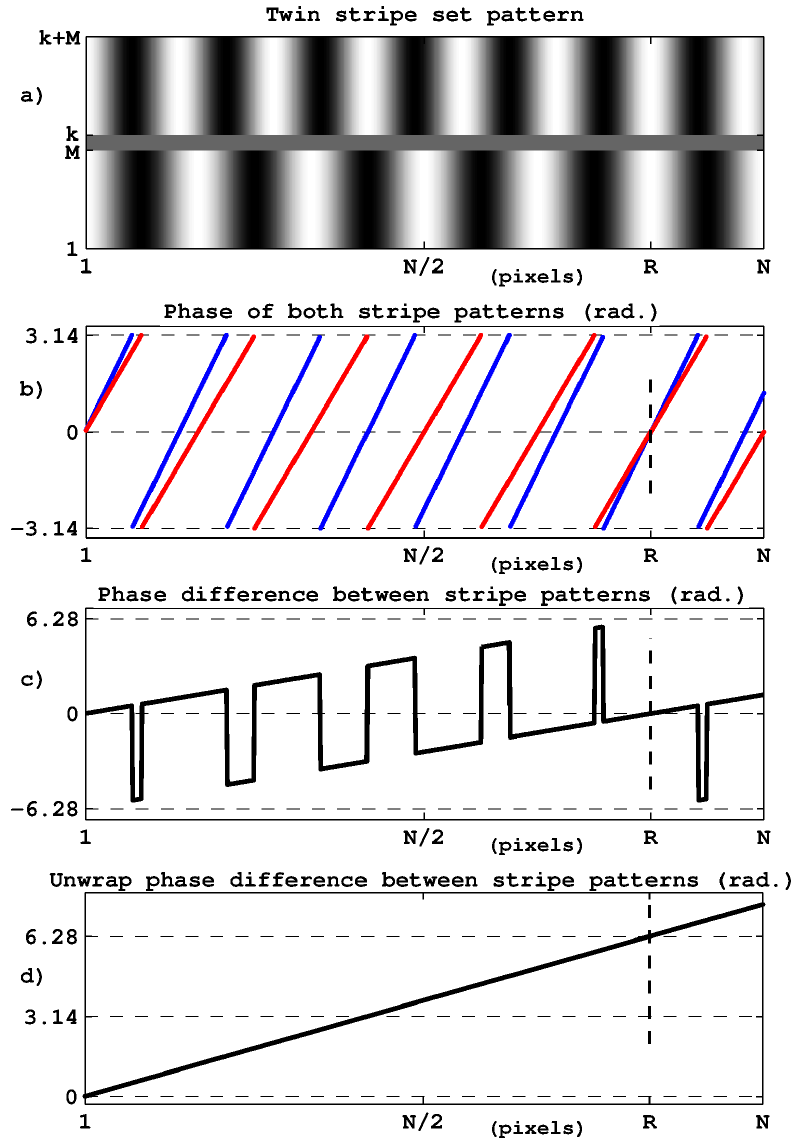
Figure 2. Extended unambiguous range by means of two stripe sets with different